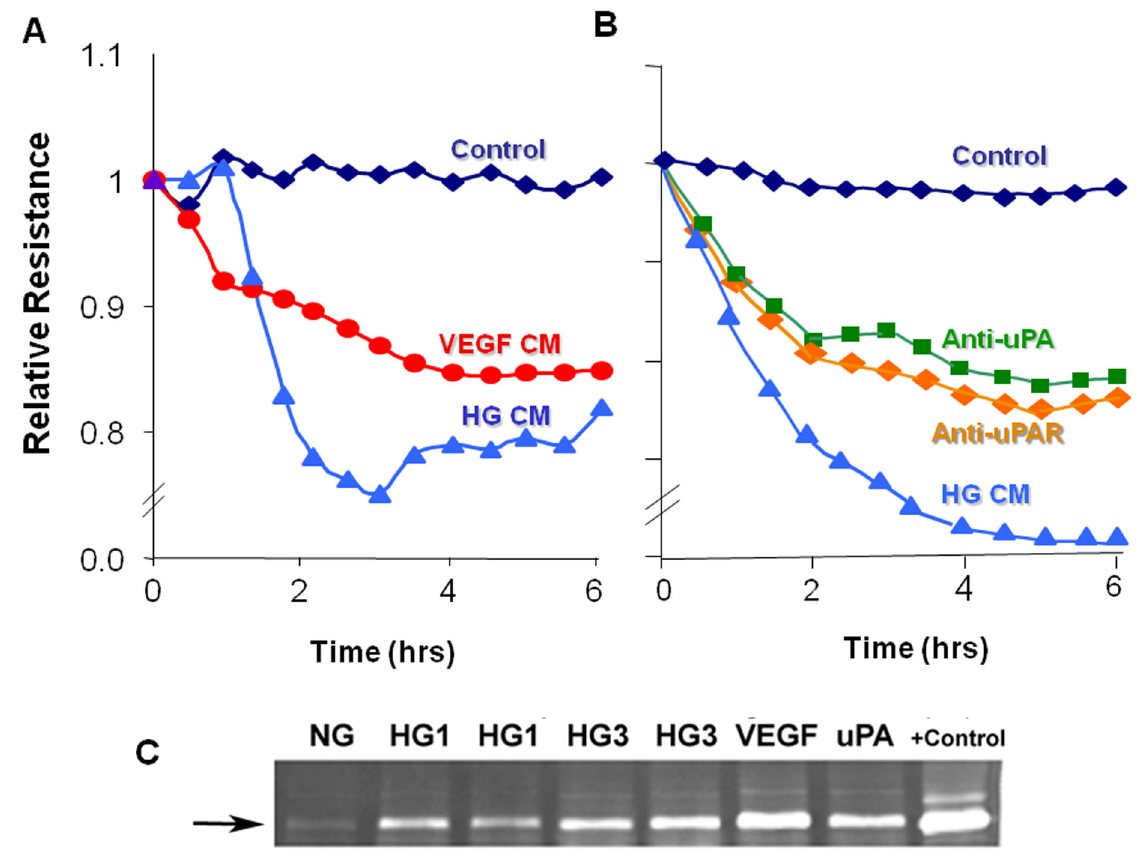
Figure 6. High glucose-induced permeability increase. Endothelial monolayers grown in ECIS microarray slides were treated with conditioned media from endothelial cells treated with high glucose (HG CM) or VEGF (VEGF CM) and tested for effects on TER (transcellular electrical resistance). Serum free medium was used as control. TER was markedly reduced by HG CM or VEGF CM (A). HG CM-induced decreases in TER were prominently reduced by pretreatment of the cultures with anti-uPA or anti-uPAR antibodies (B). Gelatin zymograms prepared using medium conditioned by cells treated with high glucose for 1 day (HG1) or 3 days (HG3) or with VEGF or uPA showed prominent increases in MMP9 activity as compared with medium from normal glucose controls (NG) (C). +Control =